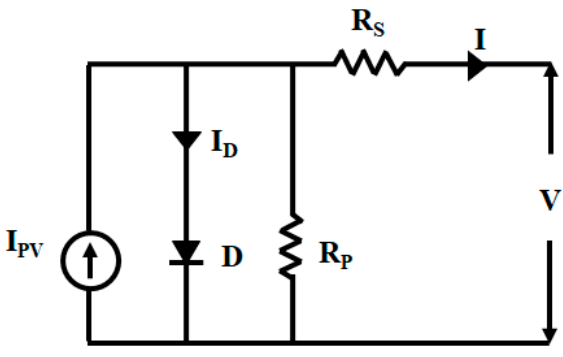
Figure 2. Photo voltaic ( PV) panel–equivalent circuit.